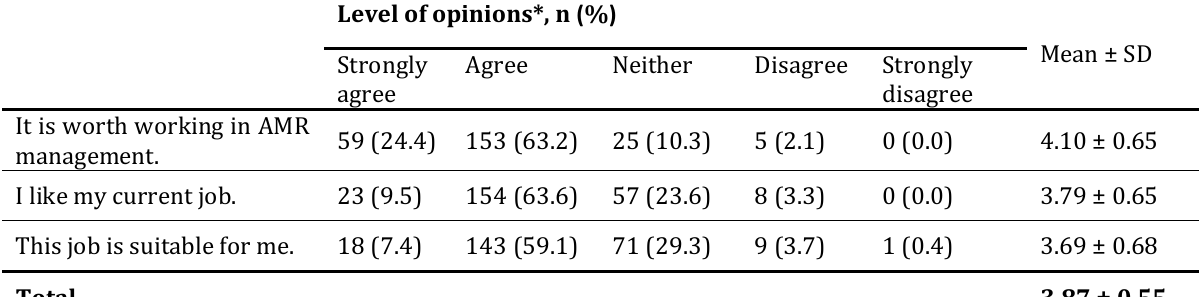
Table 2: Pharmacists’ opinions on AMR